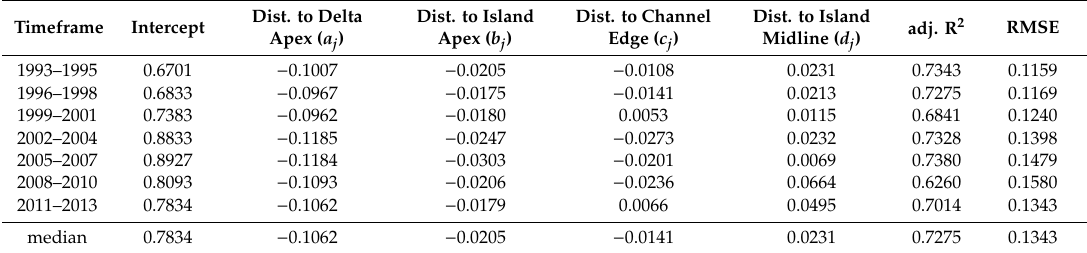
Table 1. Linear regression model coe ffi cients to predict elevation (m NAVD88) from geometric delta and island features (e.g., Figure 3), and median coe ffi cients overall. Distances in